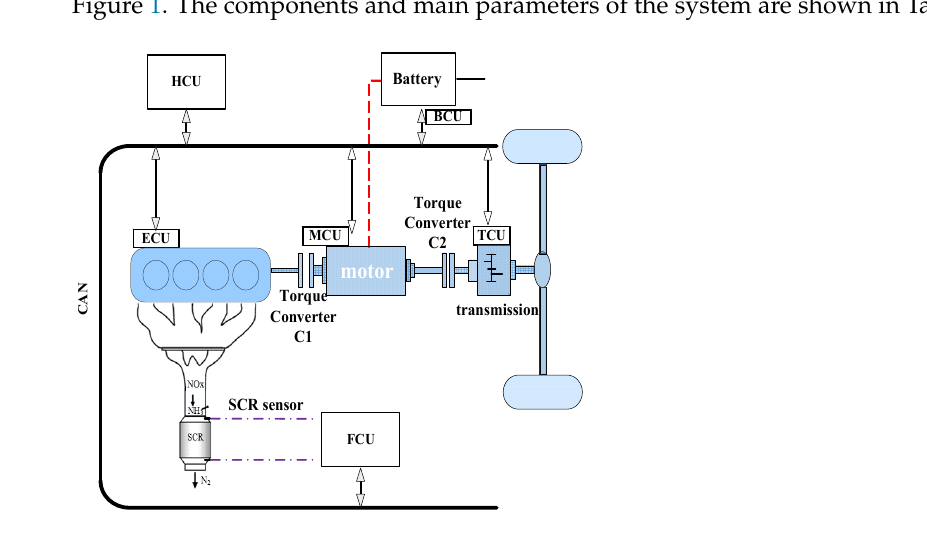
Figure 1 . Structure of the single ‐ shaft parallel PHEV. Figure 1. Structure of the single-shaft parallel PHEV. Table 1. Main parameters of the